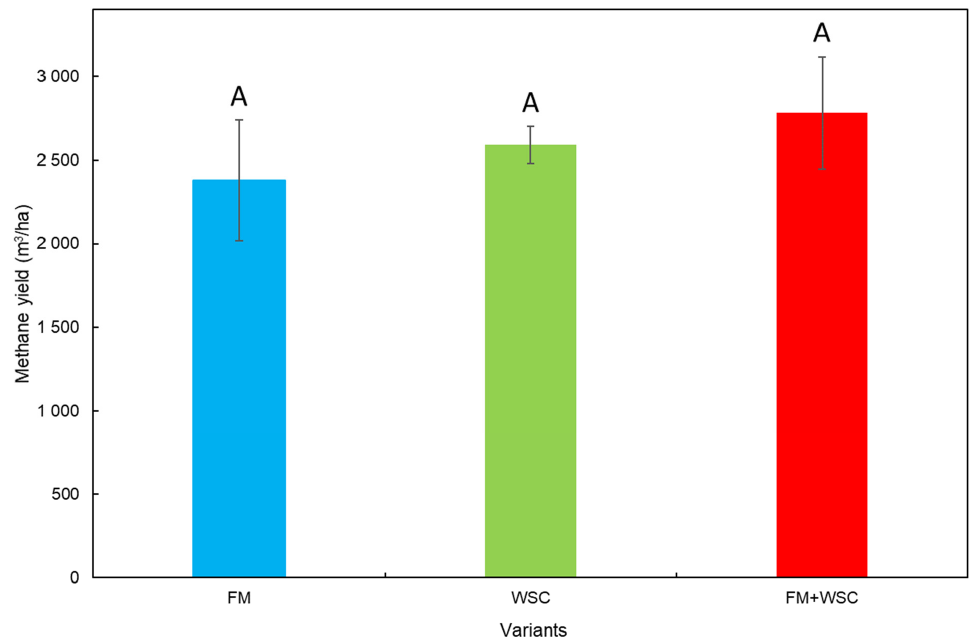
Figure 6. Methane yield based on the yield of fresh biomass (mean of measured values (n = 3) ± SD). FM—fodder mallow, WSC—white sweet clover. Different capital letters indicate significant differences ( p < 0.05).